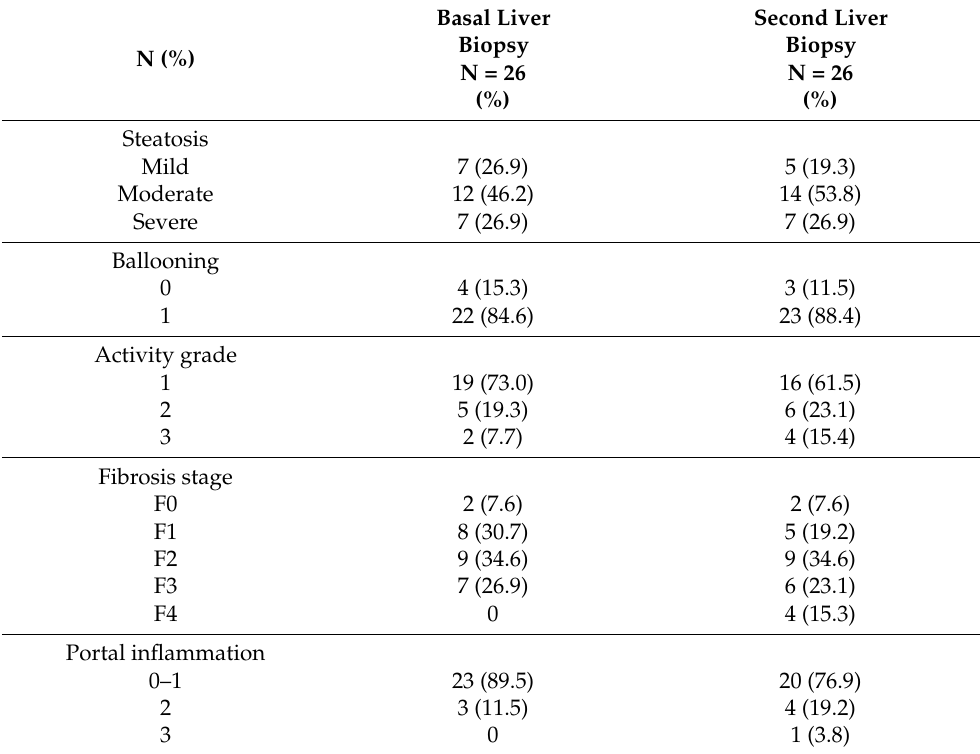
Table 2. Histological features of patients with paired